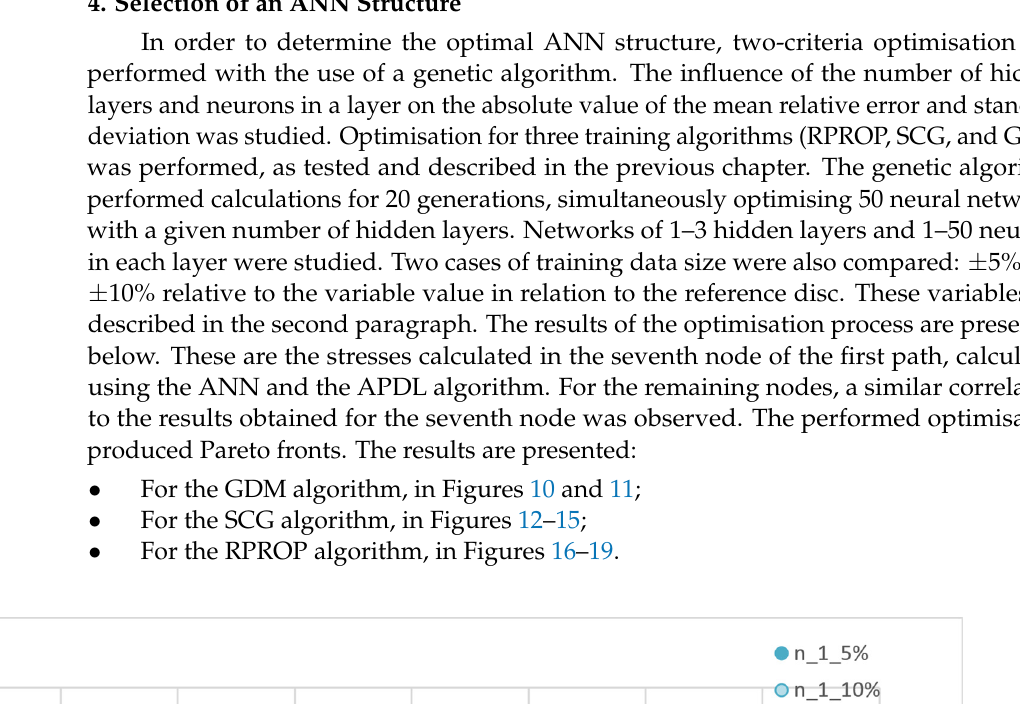
Figure 11. Pareto fronts for all networks trained using the GDM algorithm, in the zone of highest accuracy. Based on the error distribution and standard deviation, it was found that the GDM algorithm is unable to perform the task regardless of the network structure. The sensitivity of the algorithm was observed only with respect to the span of the database. Figure 11 clearly shows two bands corresponding to the database span of 10% and 5%. During op- timisation, a lack of sensitivity to the training accuracy was noticed in relation to the num- ber of hidden layers and the number of neurons in the layer. Figure 12. Pareto fronts for all networks trained using the SCG algorithm.